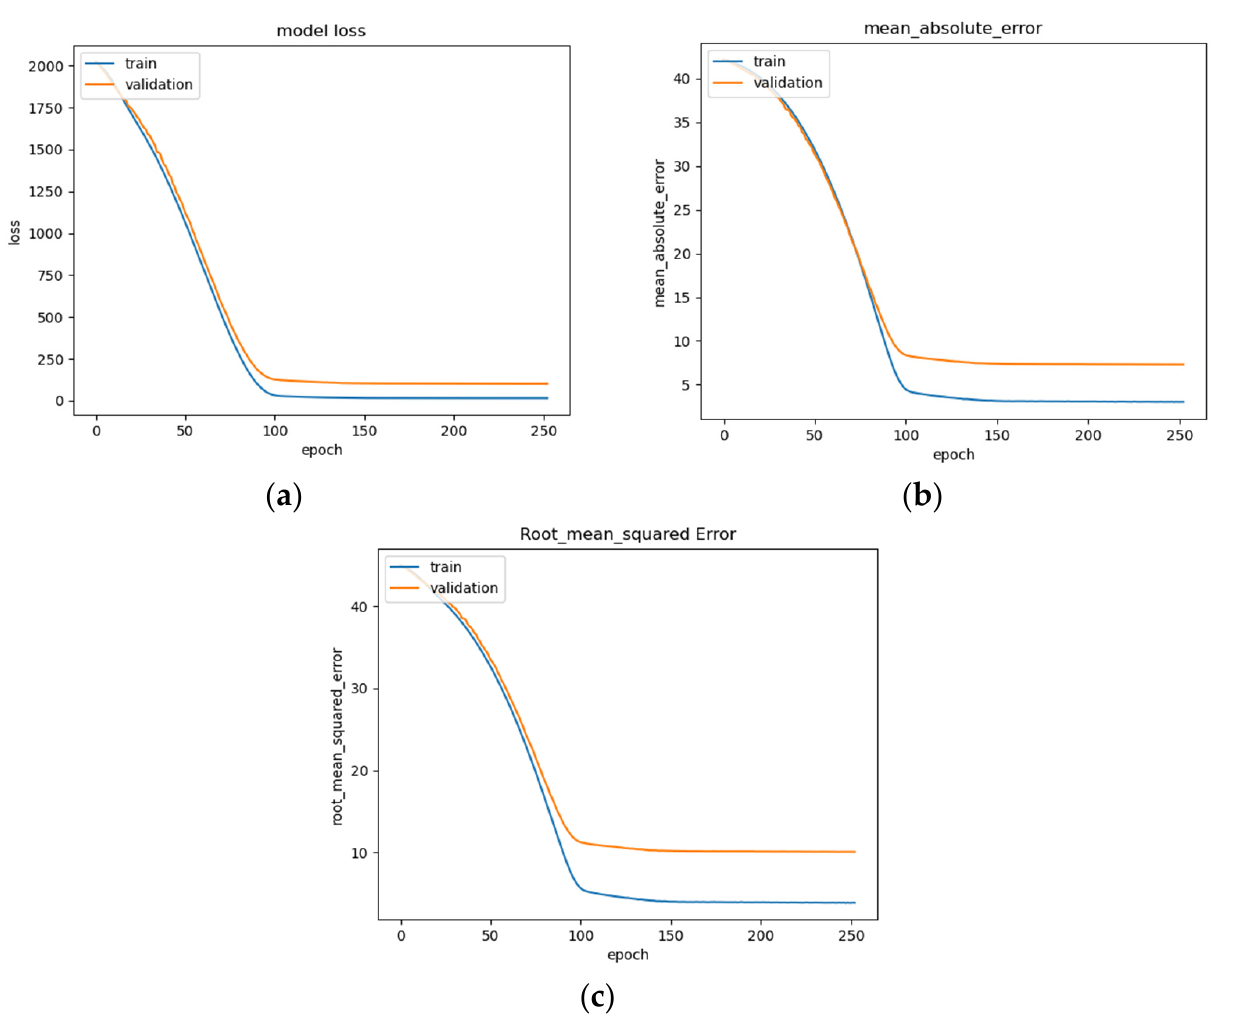
Figure 15. BLSTM model performance: ( a ) Loss (MSE) of BLSTM model trained on raw EEG data with regression analysis; ( b ) MAE of BLSTM model trained on raw EEG data with regression analysis; ( c ) RMSE of BLSTM trained on raw EEG data with regression analysis. Table 3. Results of each model from regression analysis.